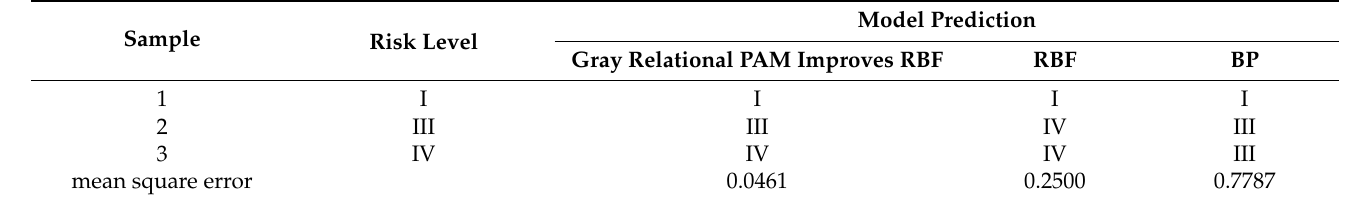
Table 9. Gray relational PAM improved RBF neural network tunnel water inrush risk assessment